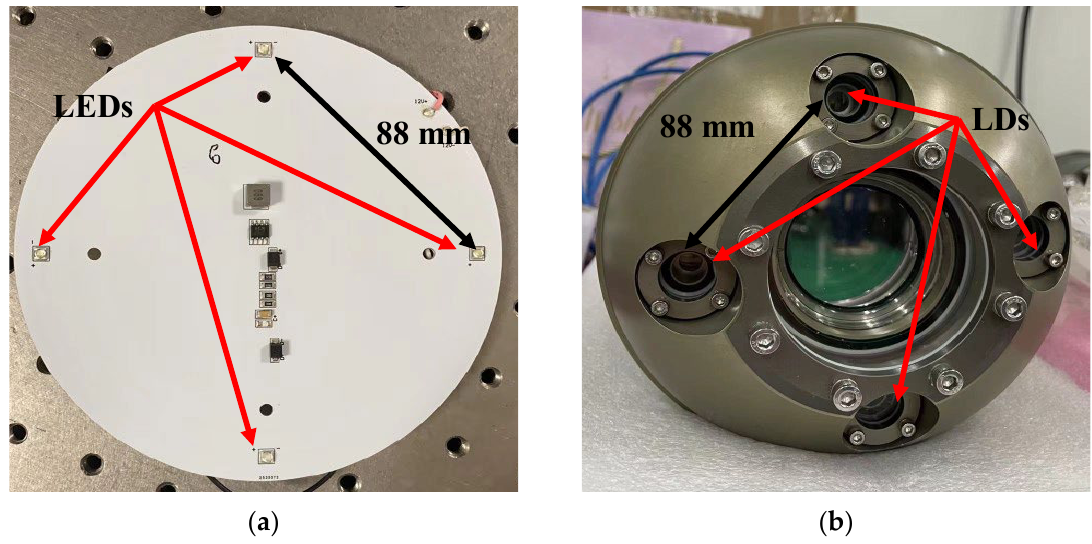
Figure 1. Optical beacons: ( a ) A cross-light beacon composed of three 520 nm LEDs and one 450 nm LED; ( b ) an optical communication probe composed of four 520 nm laser diodes.